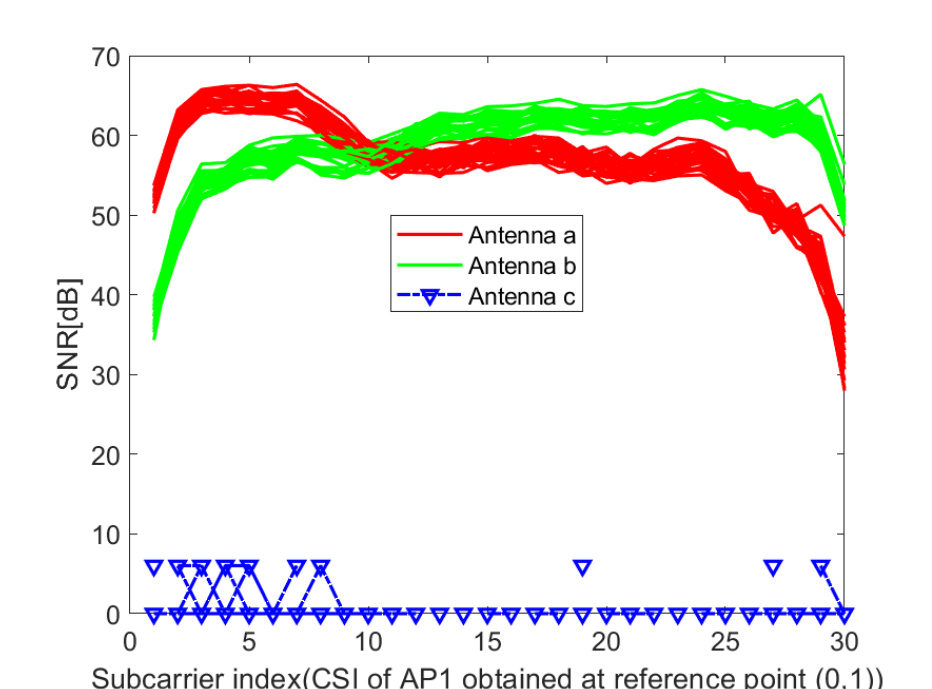
Figure 6. Raw CSI obtained on different receiving antennas at reference point (0,1) of AP1 in the corridor of IT1 building.